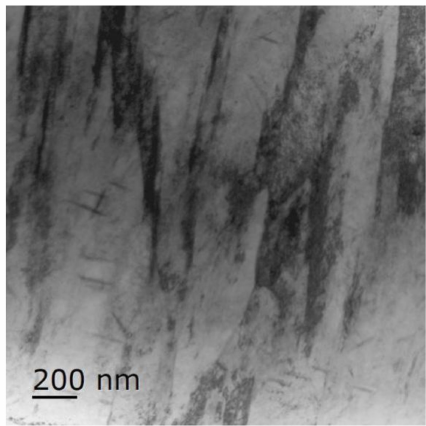
Figure 14. Flake-like and lath martensite.